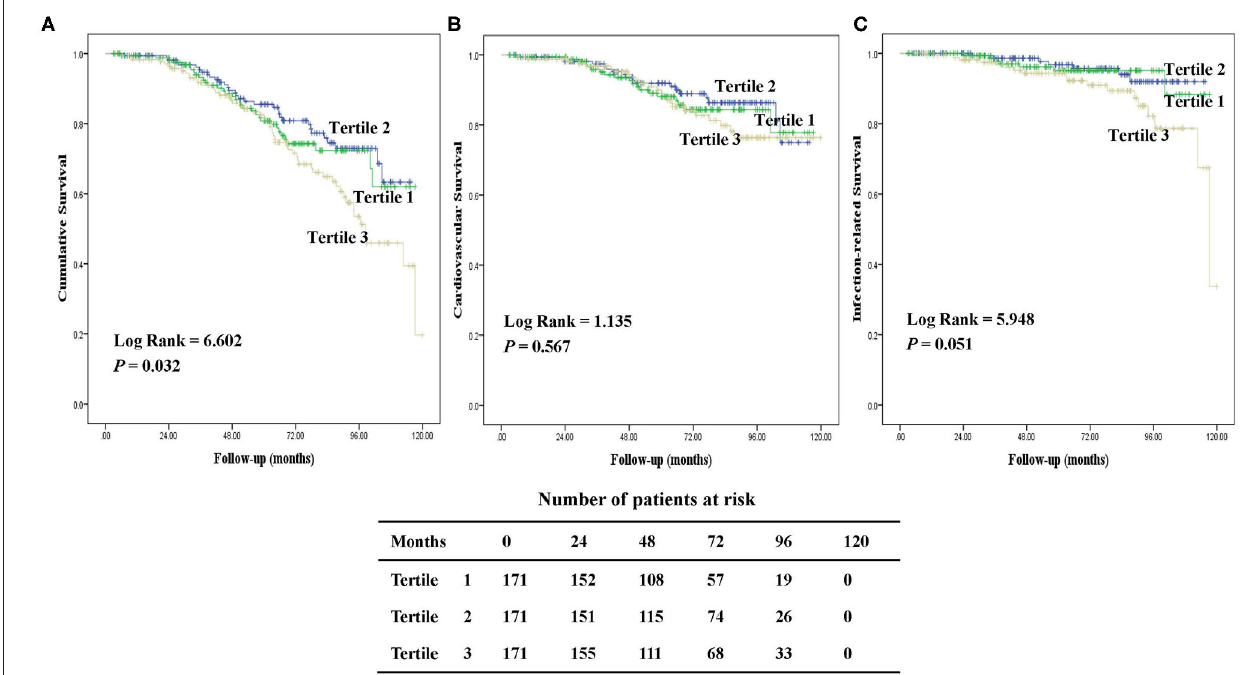
FIGURE 3 | Kaplan-Meier survival curves for patients with tertiles of serum hepcidin-25. Cumulative mortality curves for all-cause mortality (A) , cardiovascular mortality (B) , and infection-related mortality (C) , according to the serum hepcidin-25 level at baseline.